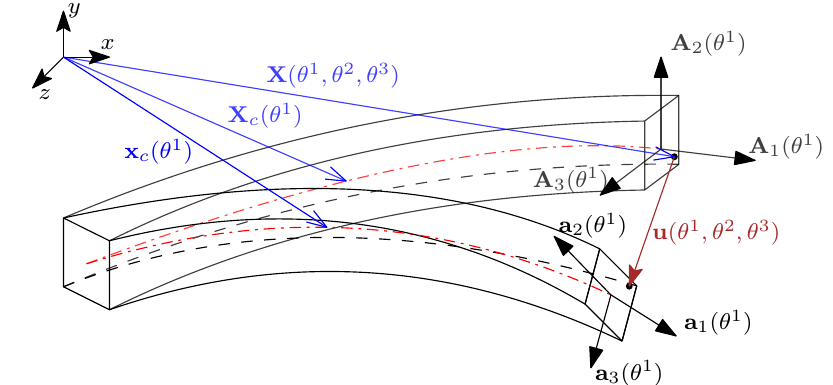
Figure 2. Illustration of the beam in its undeformed and deformed configurations.